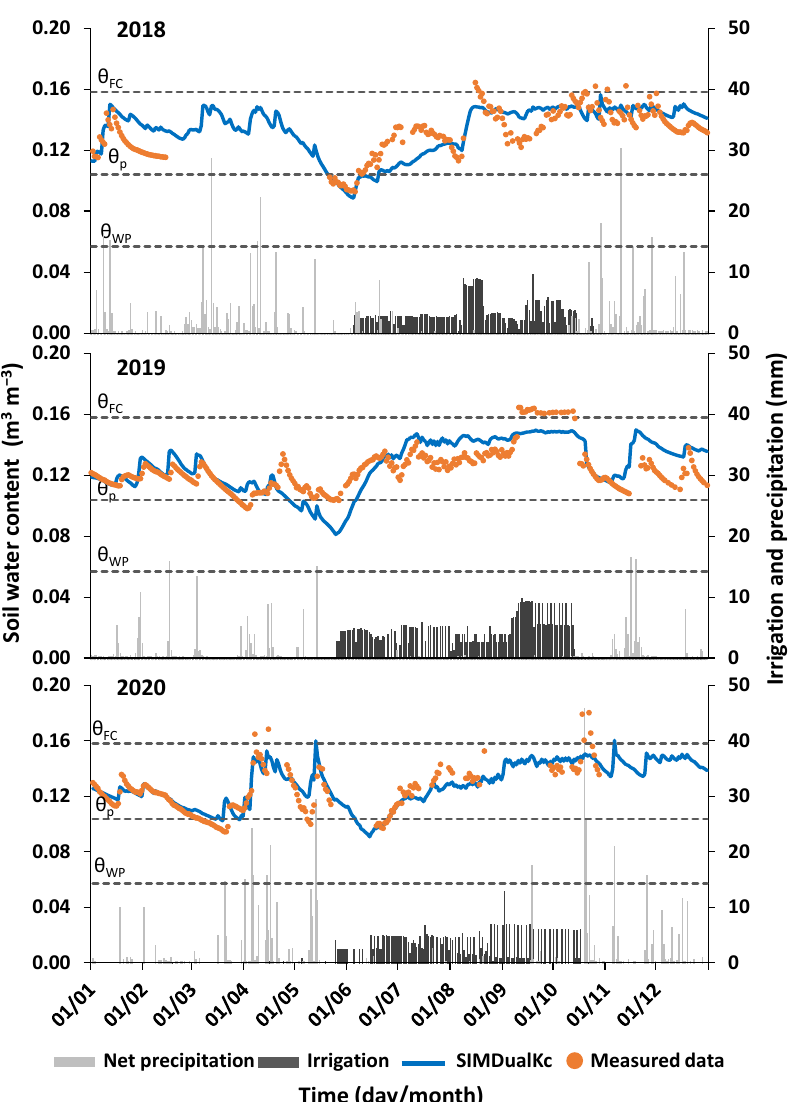
Figure 4. Measured and simulated soil water contents in the vineyard of Samora Correia during the 2018–2020 growing seasons ( θ FC , θ WP , and θ p refer to soil water contents at field capacity, the wilting point, and at the depletion fraction for no stress, respectively).